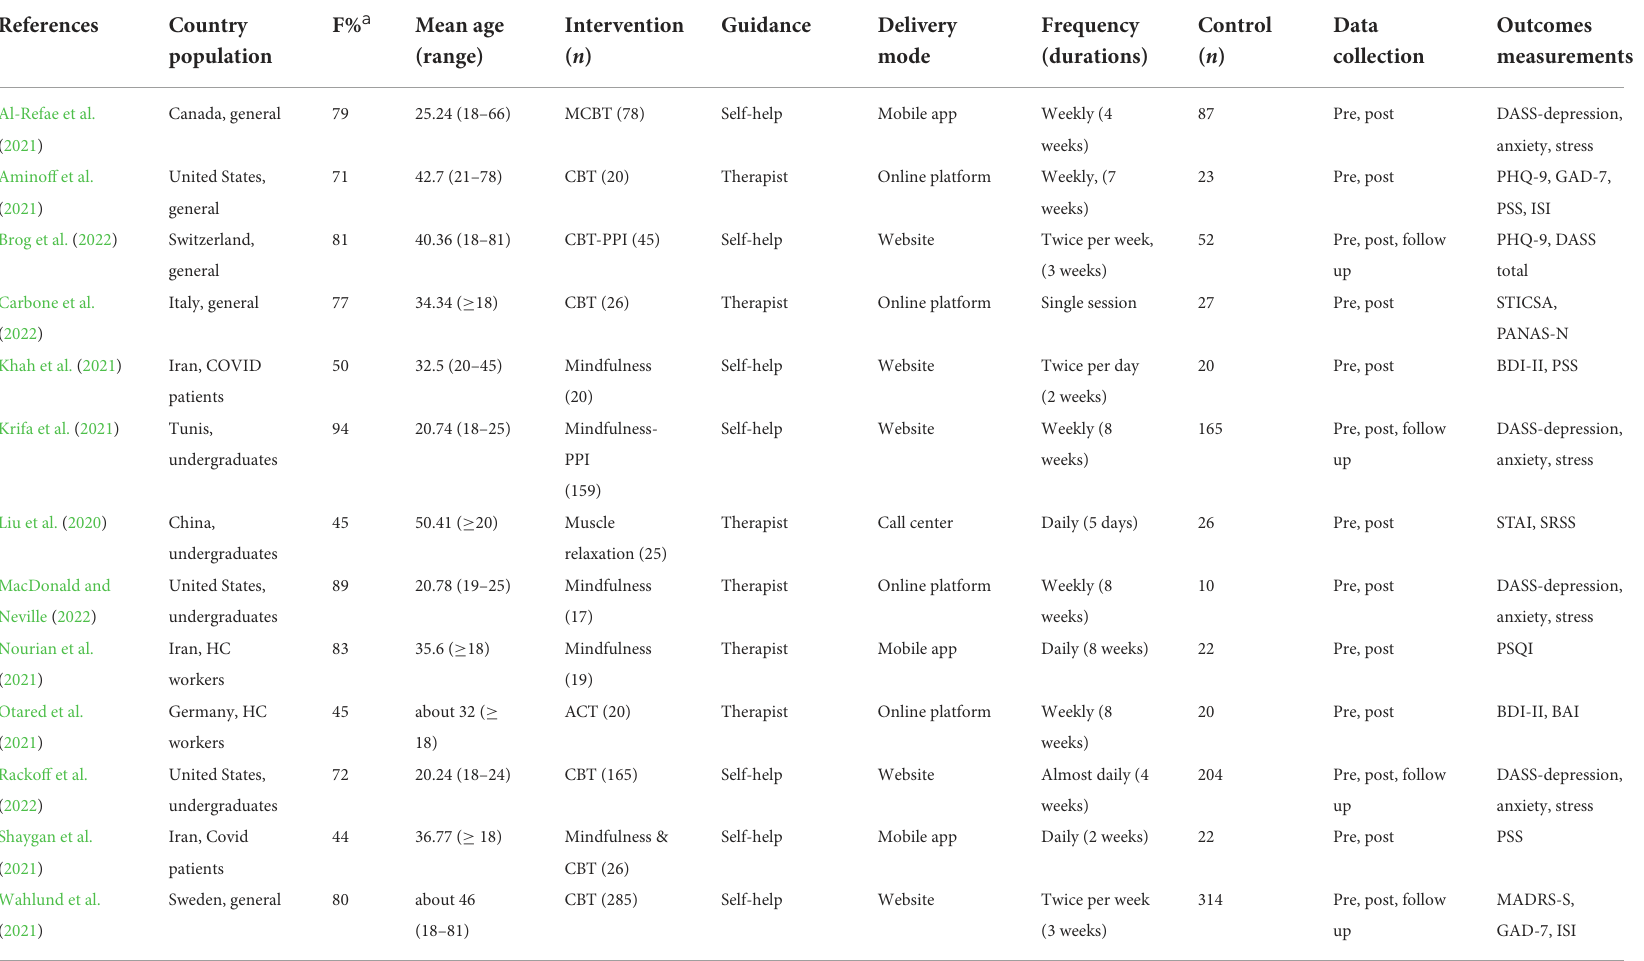
TABLE 2 Characteristics of studies included in the